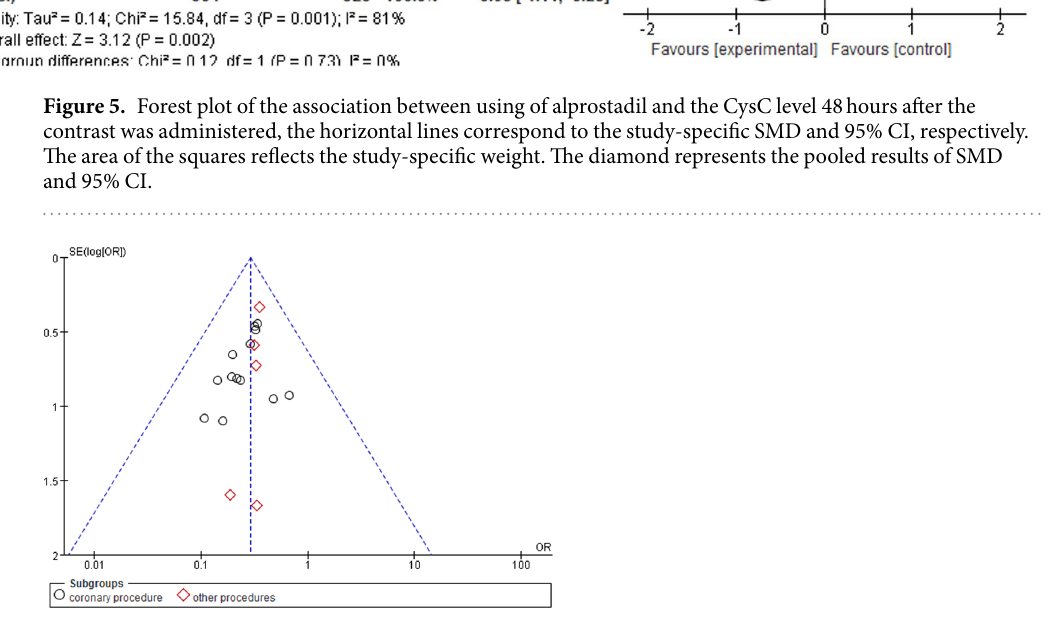
Figure 6. Funnel plot for publication bias test between using of alprostadil and the incidence of CIN. Each point represents a separate study for the indicated association. The horizontal and vertical axis correspond to the OR and confidence limits. OR odds ratio, SE standard